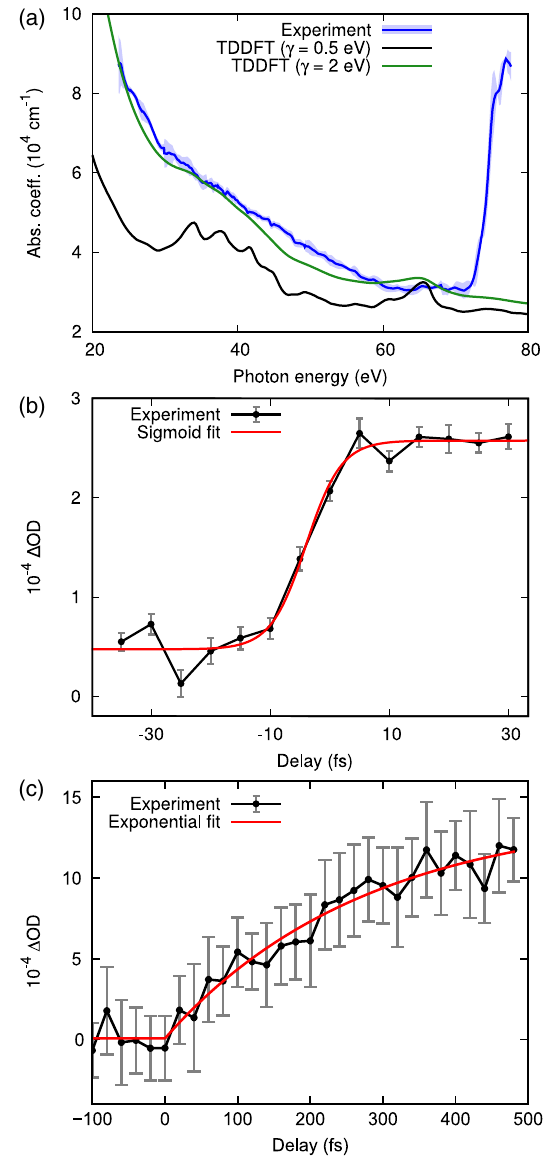
FIG. 1. (a) Measured absorption coefficient of aluminum (blue line; the standard error is shaded) compared to TDDFT calculations with different line-broadening parameters (green line ¼ 2 eV, black line ¼ 0 . 5 eV). No core-level absorption was taken into account for TDDFT at 73 eV. (b,c) Optical density change Δ OD between 42 eV and 44 eV after NIR excitation (black line; gray bars show standard error). (b) Few- femtosecond dynamics, reflecting the electronic heating. The absorbed laser fluence is fitted with a sigmoid function to the optical density change (red line) with a rise time of 13 . 0 (cid:2) 3 . 2 fs. (c) Subpicosecond lattice response (black line) and an exponen- tial fit (red line) with a response time of 274 (cid:2) 62